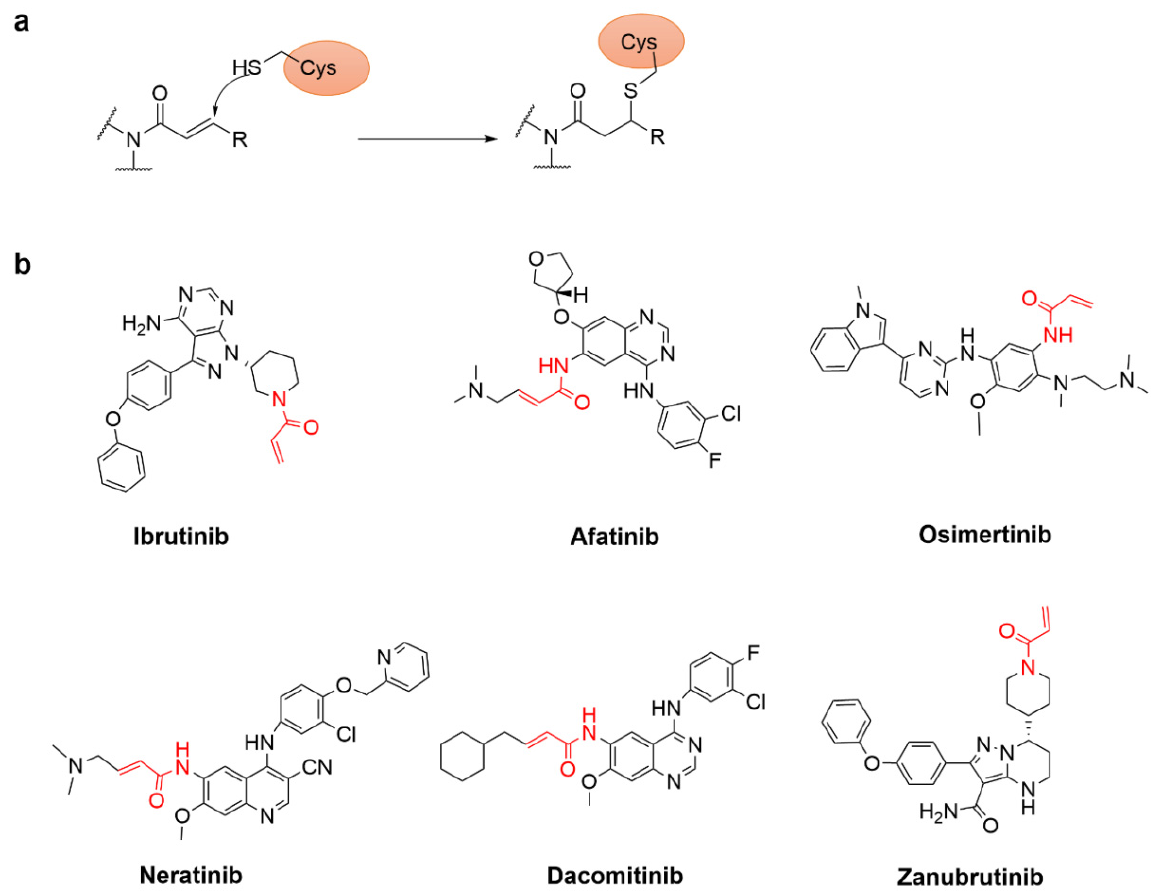
Figure 5. ( a ) The mechanism of Michael’s addition of acrylamide warheads to cysteine. ( b ) Small molecule covalent inhibitors with acrylamide warheads.